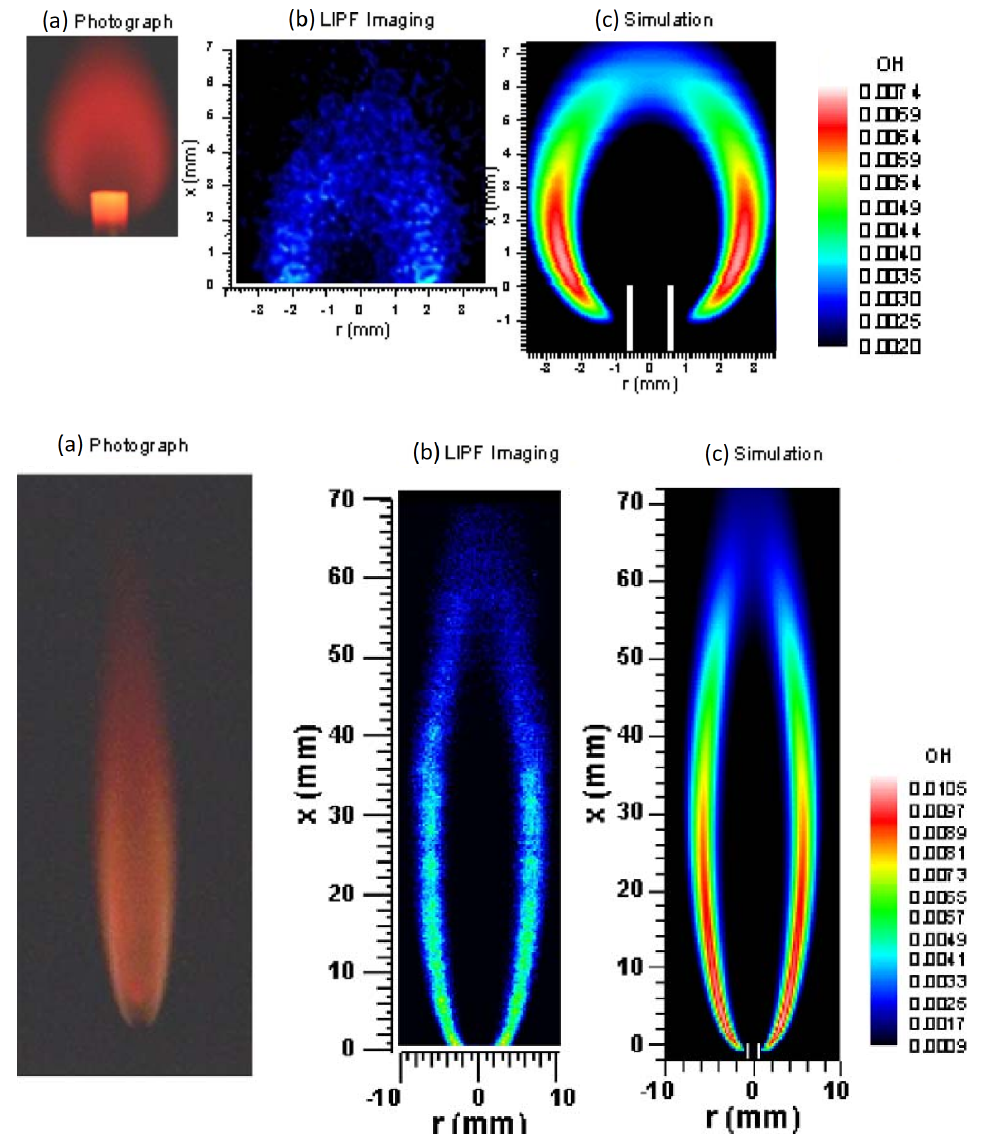
Figure 4. Experimental ( a and b in both top and bottom figures) and numerical ( c in both top and bottom figures) study of hydrogen micro-diffusion flame for different Reynolds numbers by Cheng et al. [8]. ( a ) Photograph, ( b ) single-pulse LIPF-OH image and ( c ) computed OH isopleths of the hydrogen jet diffusion flame, Top : Re = 30; Bottom : Re =